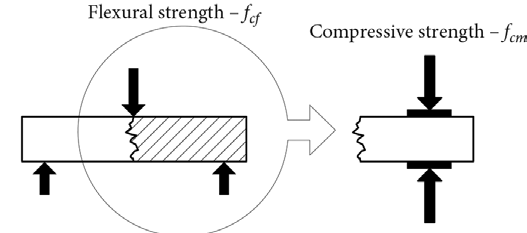
Fig. 3. Strength tests of the beams